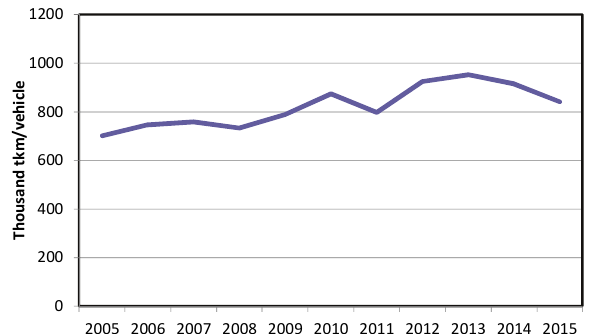
Fig. 7. Average efficiency of haulage work by the statistical vehicle at the Polish international freight transport in the years 2005–2015 [thousand tkm/vehicle] (diagram based on [4] and [5]